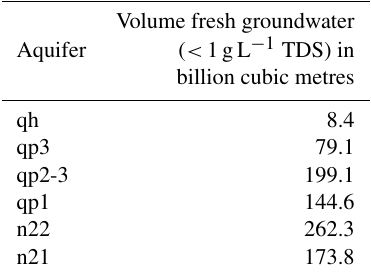
Table 3. Volume of fresh groundwater for each aquifer (TDS < 1gL − 1 ) in billion cubic